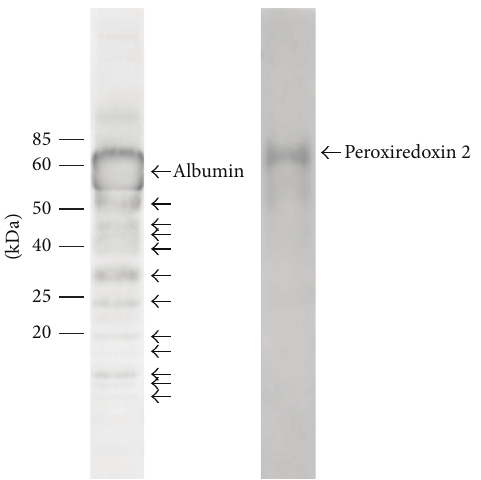
Figure 3: Western blot analysis of sham rabbit vitreous developed with anti-albumin and anti-peroxiredoxin 2. Labeled arrows corre- spond to the respective full length proteins. The unlabeled arrows for the lower molecular mass bands on the anti-albumin blot may indicate the specific cleavage fragments, which correspond with some of the differentially expressed 2D-PAGE protein